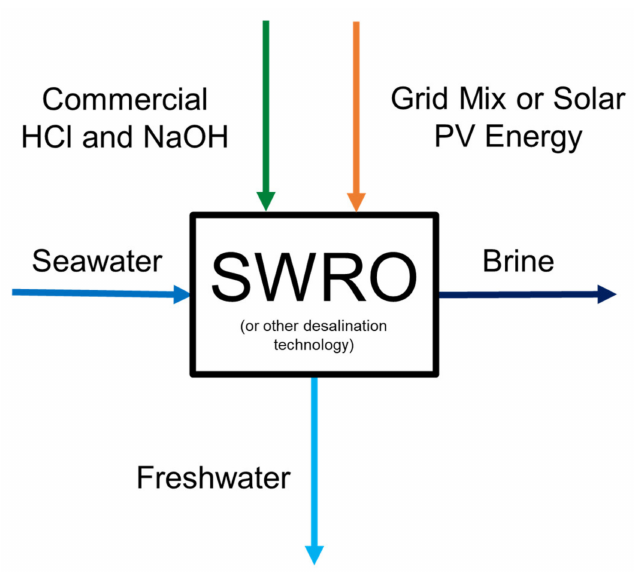
Figure 2. Alternative A0 flow